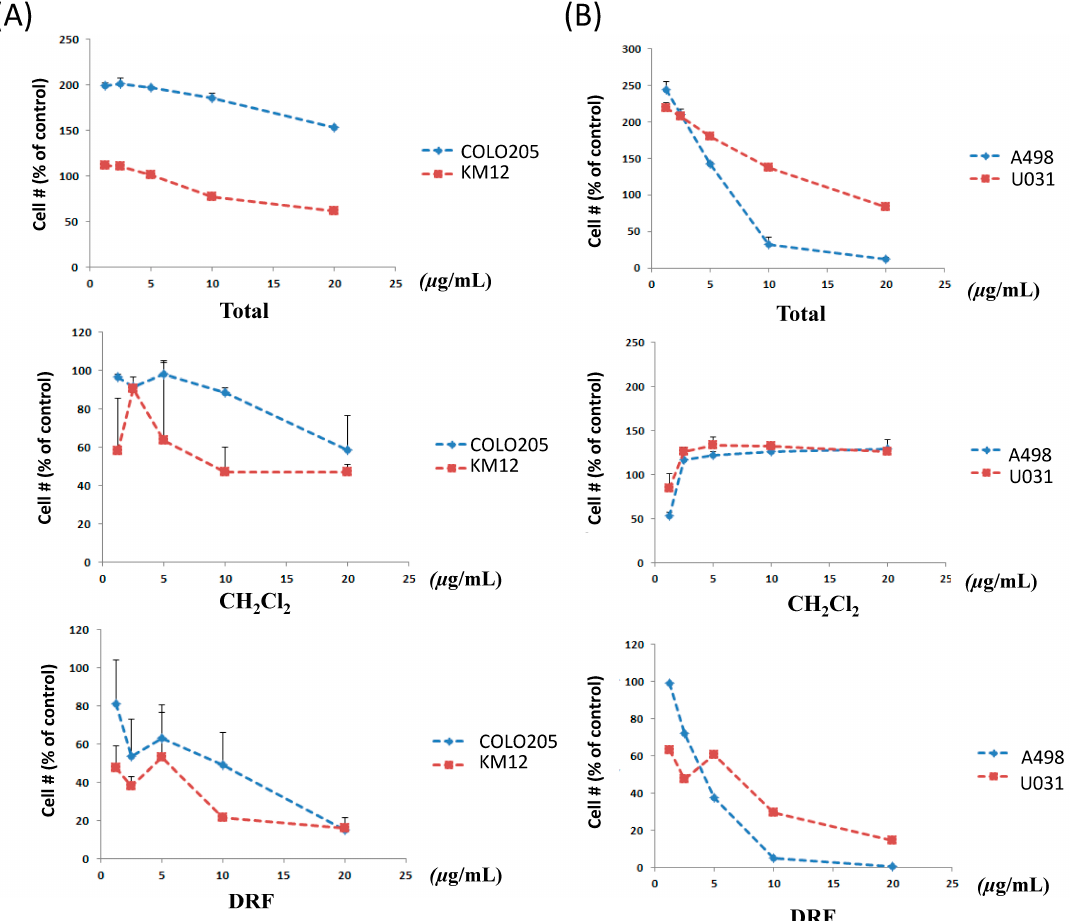
Figure 2. Cytotoxicity of total extract, CH 2 Cl 2 fraction, and DRF (diarylheptanoid-rich fractions) in colon tumor cells COLO205, KM12 ( A ) renal tumor cells A498, U031; ( B ) cell number was calculated as (A 405 of sample treated − A 405 of no cell control)/(A 405 of DMSO control − A 405 of no cell control) × 100%.